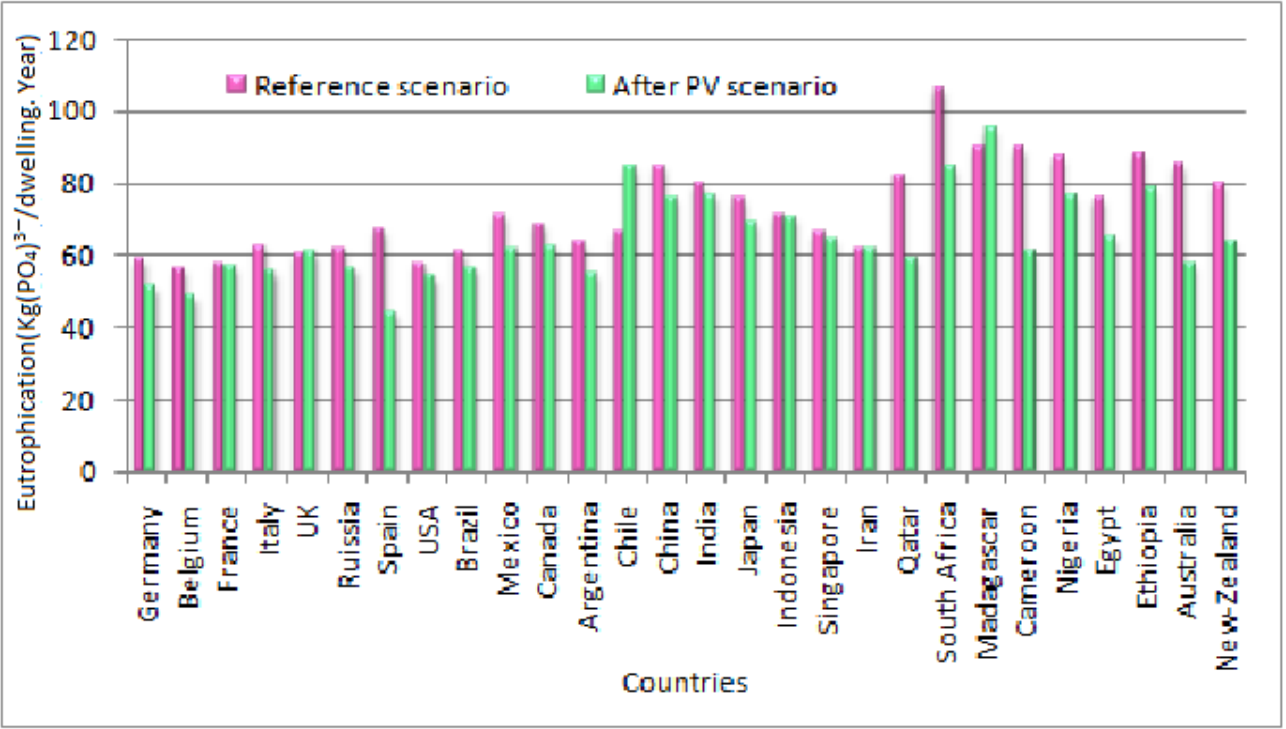
Figure 5. Comparative diagram of the acidification impact of the “Initial” and “Photovoltaic” Scenarios.